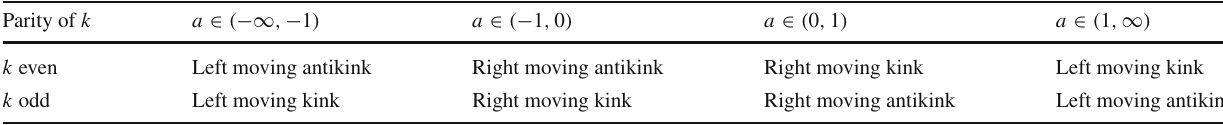
Table 2 The static background kink solutions for all a and k Parity of k a ∈ ( −∞ , − 1 ) a ∈ ( − 1 , 0 ) a ∈ ( 0 , 1 ) a ∈ ( 1 , ∞ ) k even Right moving antikink Left moving kink Left moving antikink Right moving kink k odd Right moving kink Left moving antikink Left moving kink Right moving